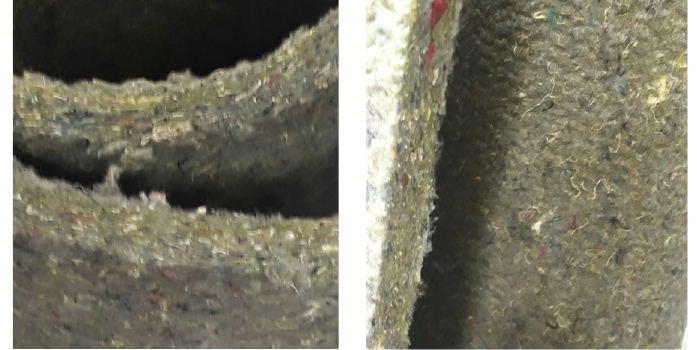
Figure 2. Materials: the textile felt